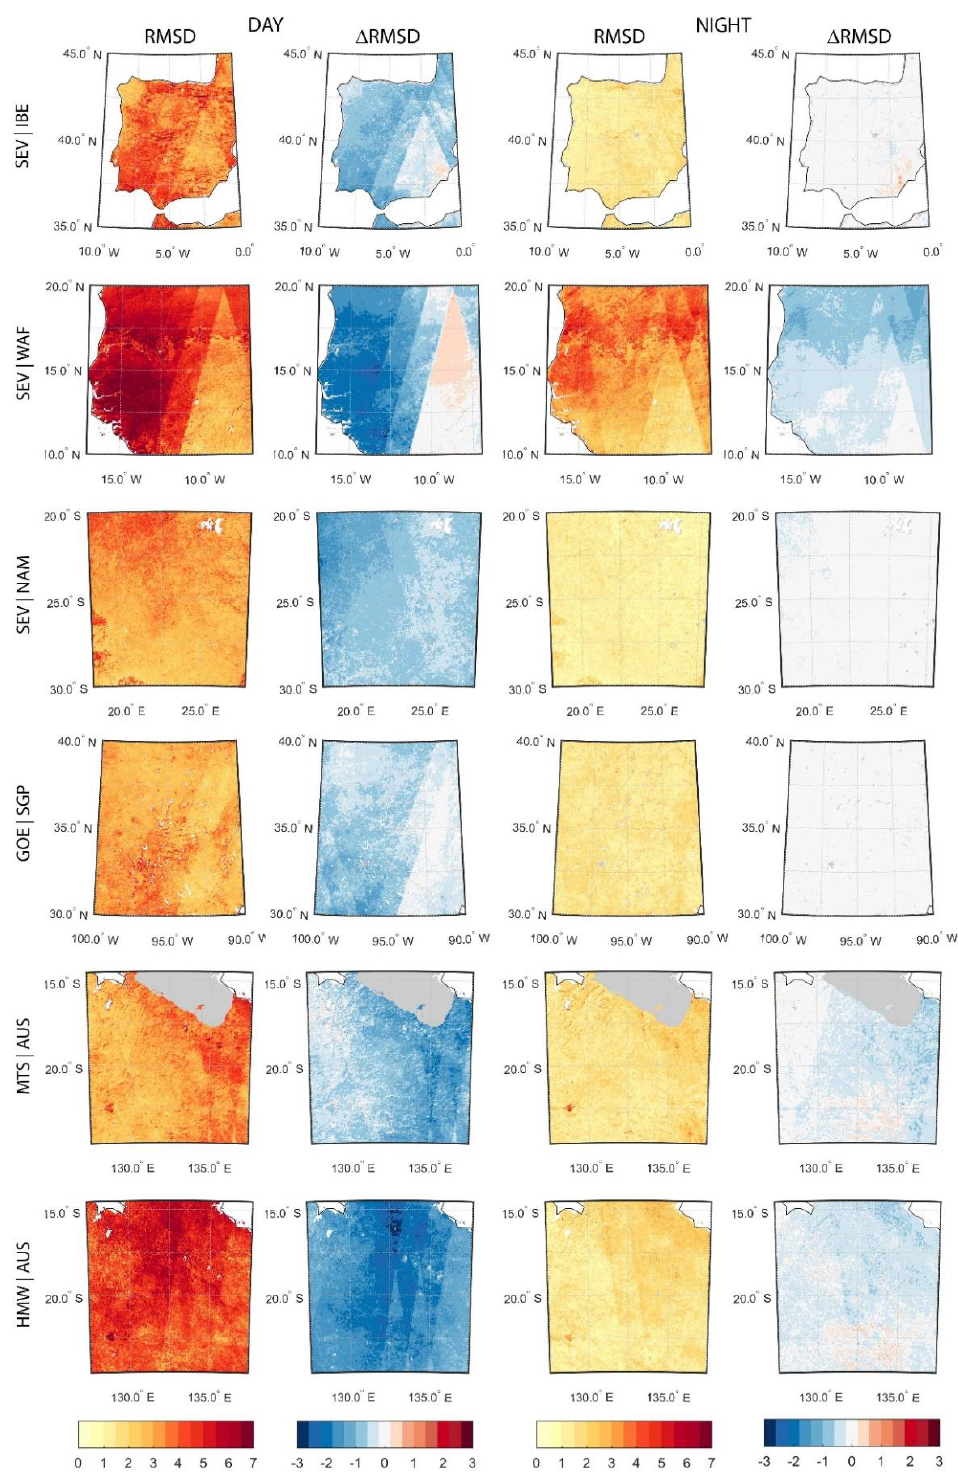
Figure 8. Spatial distribution of Root Mean Square Differences (RMSD; 1st and 3rd columns; in K) between MODIS and each geostationary sensor part of the GT_MDB, as well as the impact of LST angular correction on the RMSD (in K; as (RMSD after angular correction)–(RMSD without correction)), as given by the Kernel-Hotspot model (second and fourth columns). The geostationary satellite considered varies with area, namely: SEVIRI (SEV) over the Iberian Peninsula (IBE), West Africa (WAF) and the Namib desert (NAM); GOES (GOE) over the Southern Great Plains (SGP); and MTSAT-2 (MTS), and Himawari (HMW) over Australia (AUS).